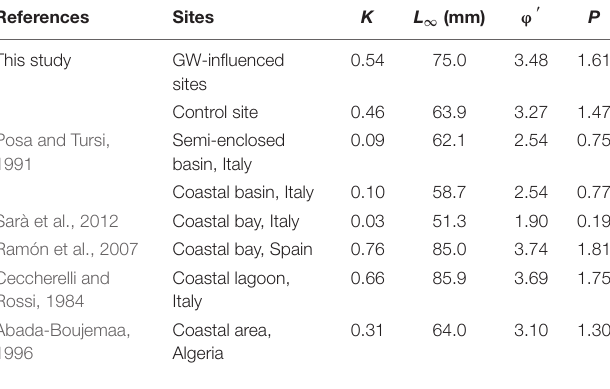
TABLE 2 | The Von Bertalanffy growth parameters and the growth performance indices values of M. galloprovincialis from this study and other coastal systems in the Mediterranean region.